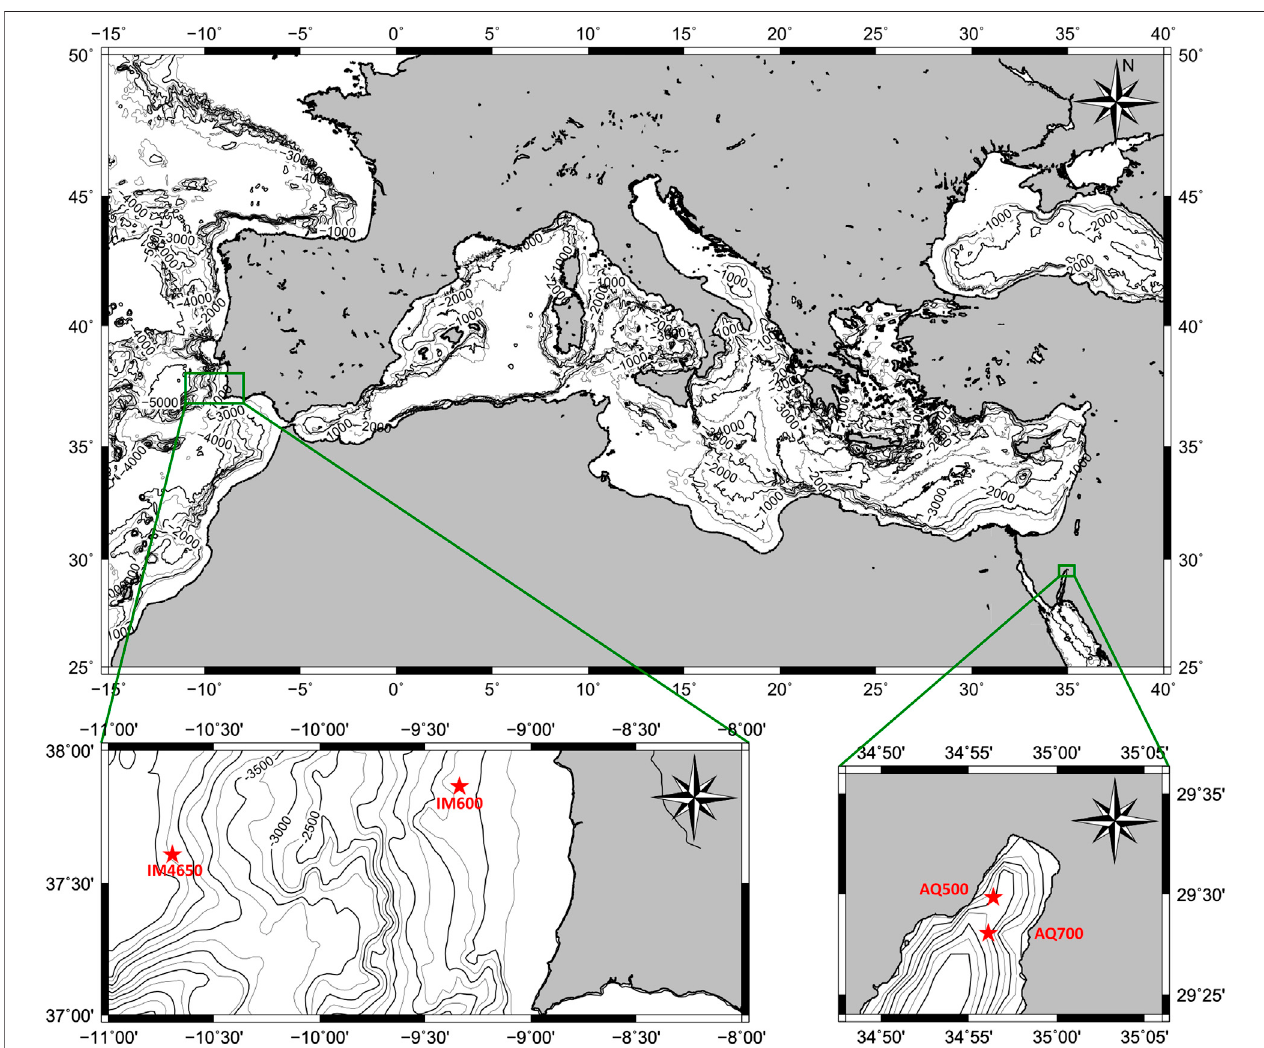
FIGURE 1 | Map of southern Europe, North Africa, and the Mediterranean. The Iberian Margin (Top) and Gulf of Aqaba (Bottom) are displayed in zoomed sub fi gures, with associated sample sites as red stars.